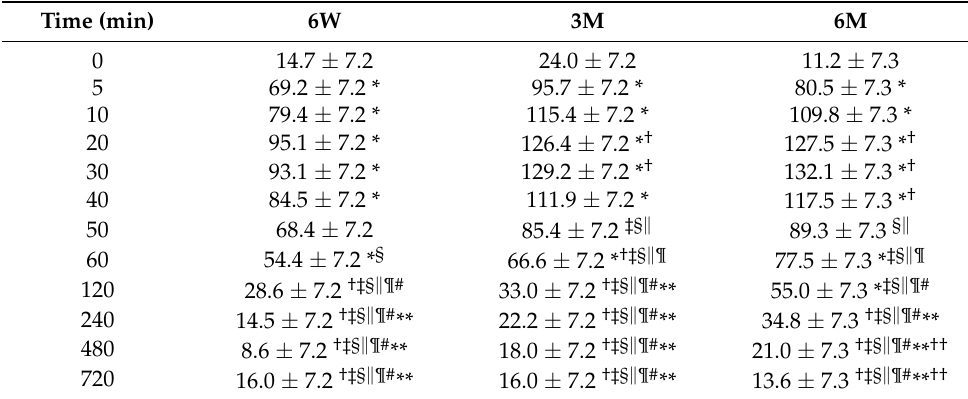
Table 2. Estimated least square means and standard error (SEM) of cortisol concentrations (nmol/L) in CAST treatment at the different time points (min) for the calves of 6 weeks (6W), 3 months (3M) and 6 months (6M) of age,